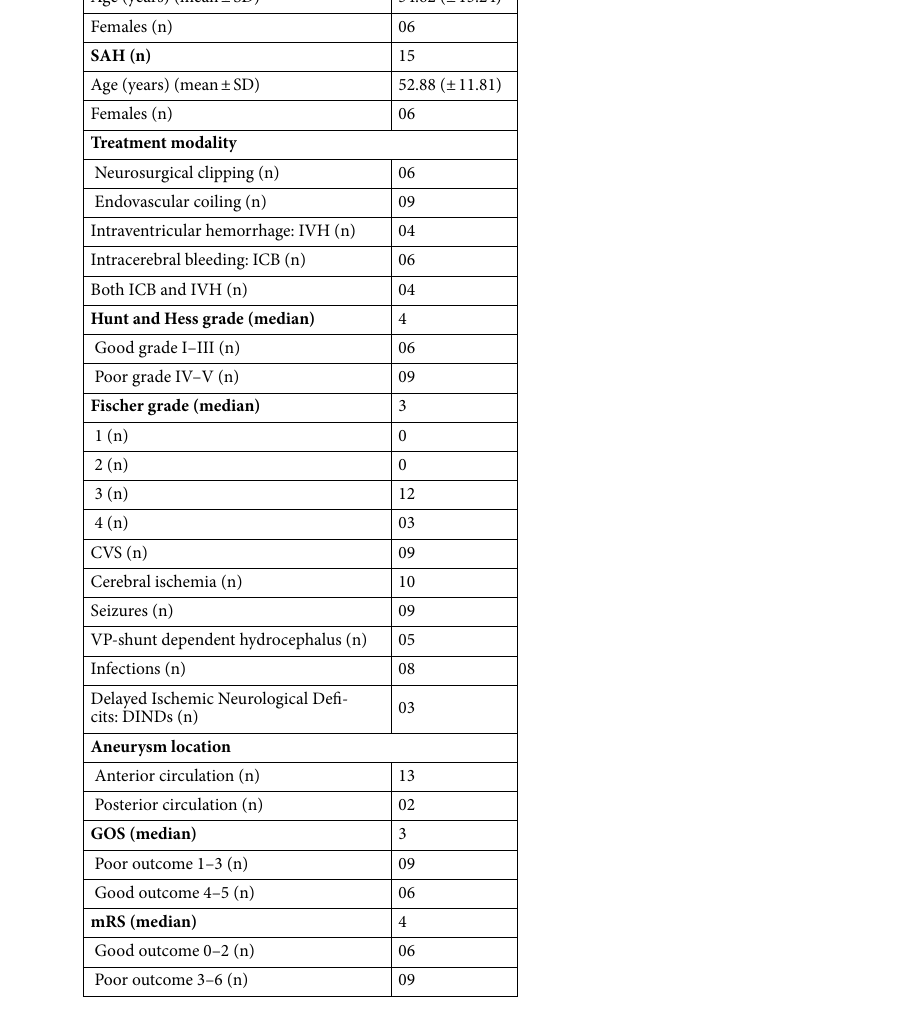
Table 1. Characters of healthy controls and SAH